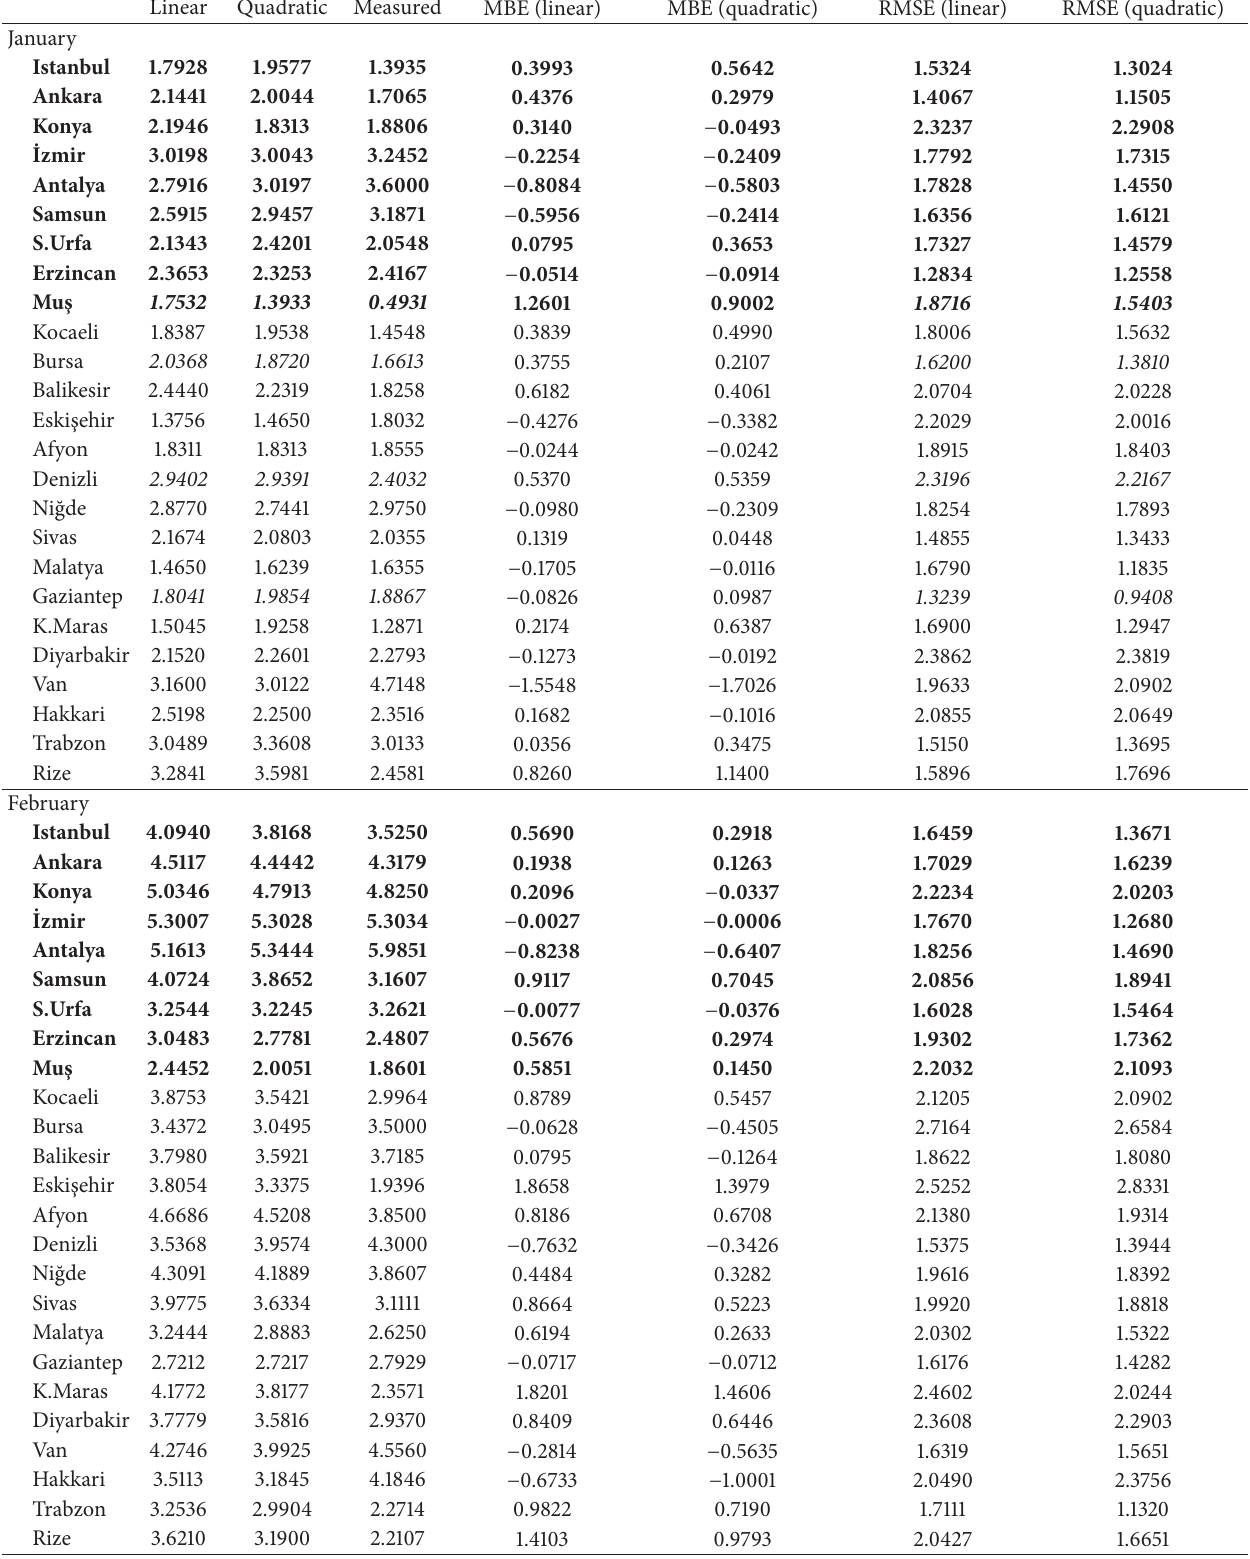
Table 2: Comparison of satellite estimates with the measured monthly mean daily sum sunshine duration for nine calibrations (bold) and 16 randomly selected testing stations (all units are in hours per